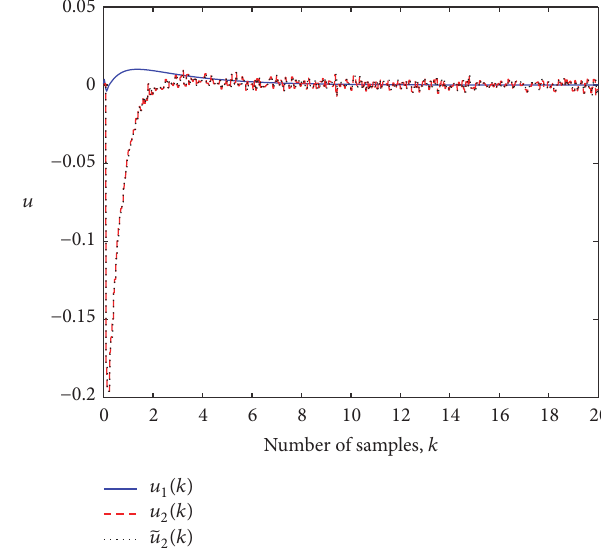
Figure 6: Rotor system controller output 𝑢 .